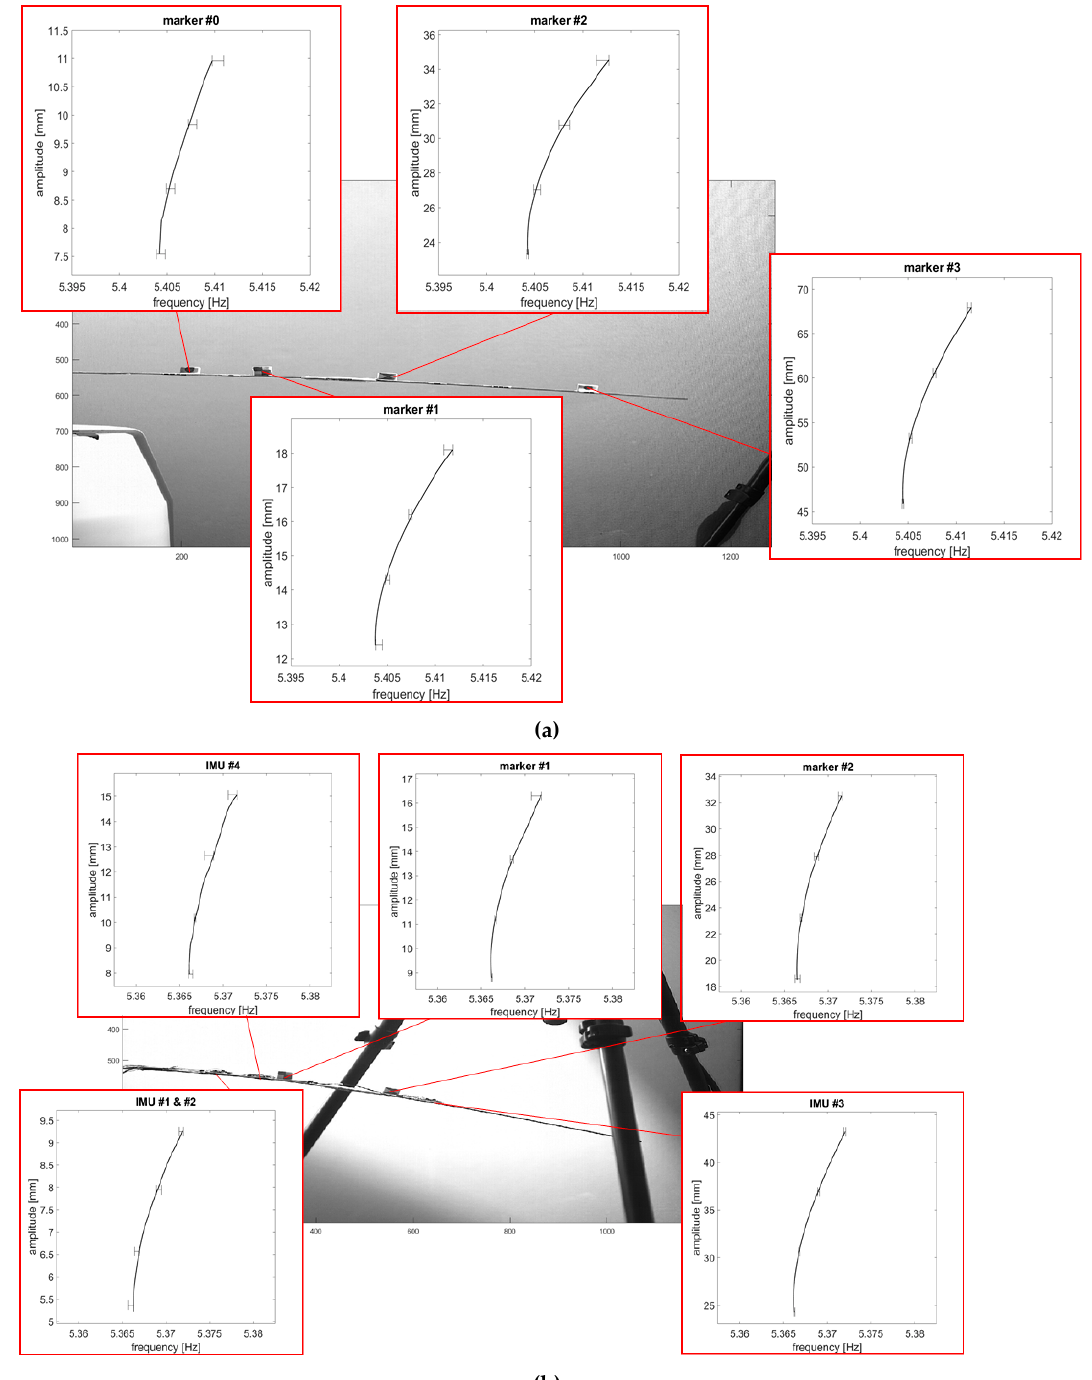
Figure 12. Video-extracted backbone curves: ( a ) Unloaded condition and ( b ) sensor-loaded condition. The portrayed curves come from the first round of measurements; error bars show the range of frequencies for the three rounds at four fixed instants.